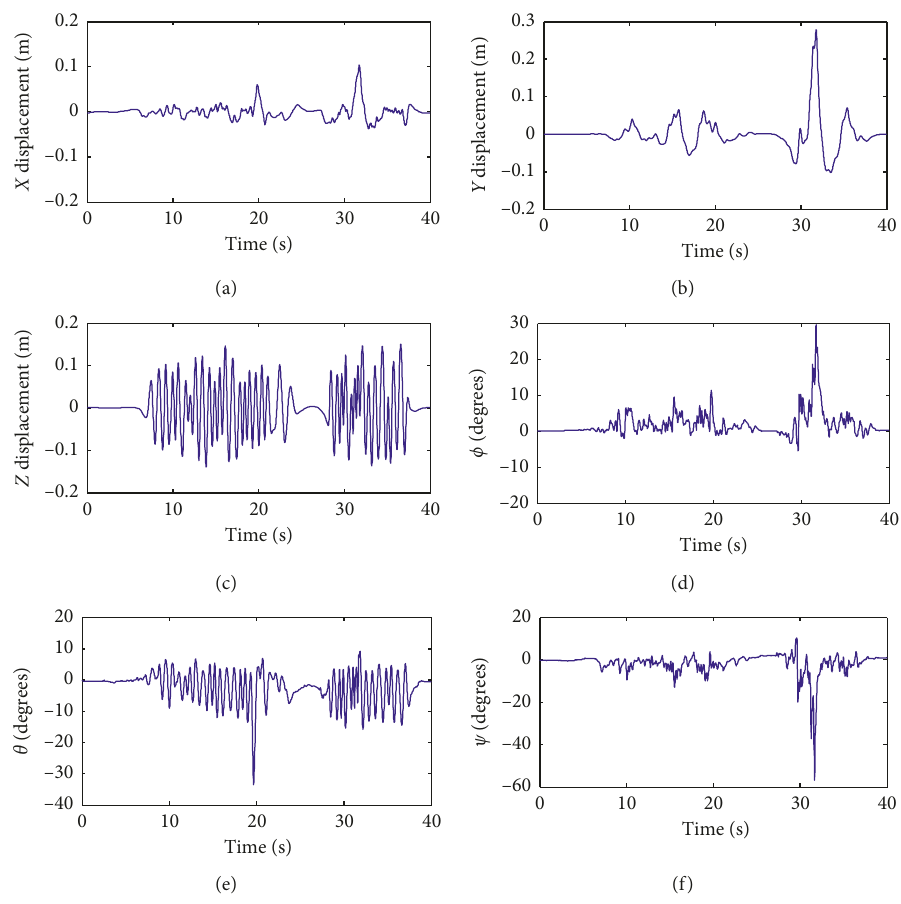
Figure 8: 6-DOF motion information of the test carrier: (a) X displacement; (b) Y displacement; (c) Z displacement; (d) roll angle; (e) pitch angle; (f) yaw